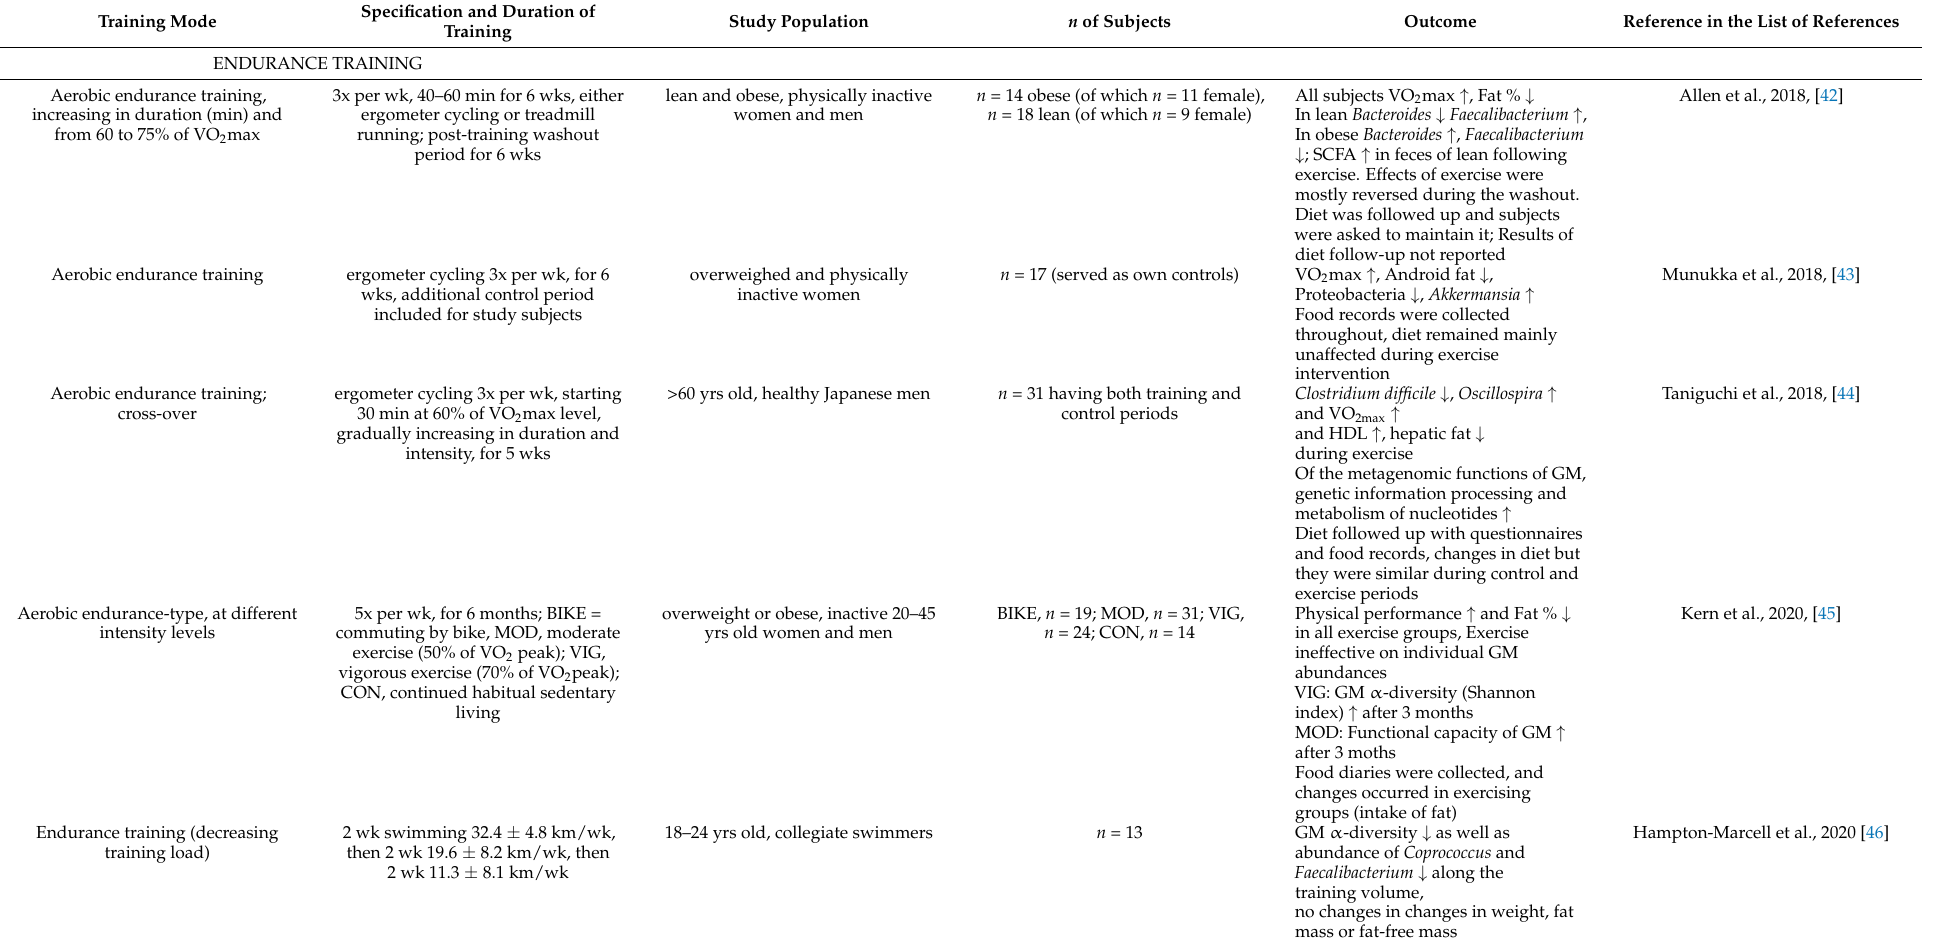
Table 1. The main findings from the original research publications reporting effects of longer-term exercise training on the gut microbiota. Only the outcomes related to either training or the gut microbiota are shown in the